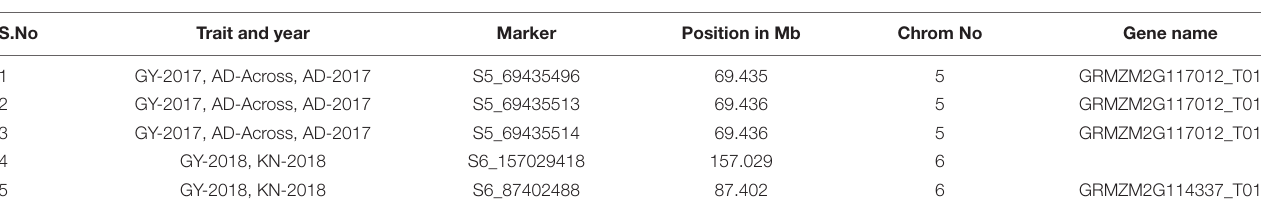
TABLE 3 | Details of marker-trait associations common for multiple